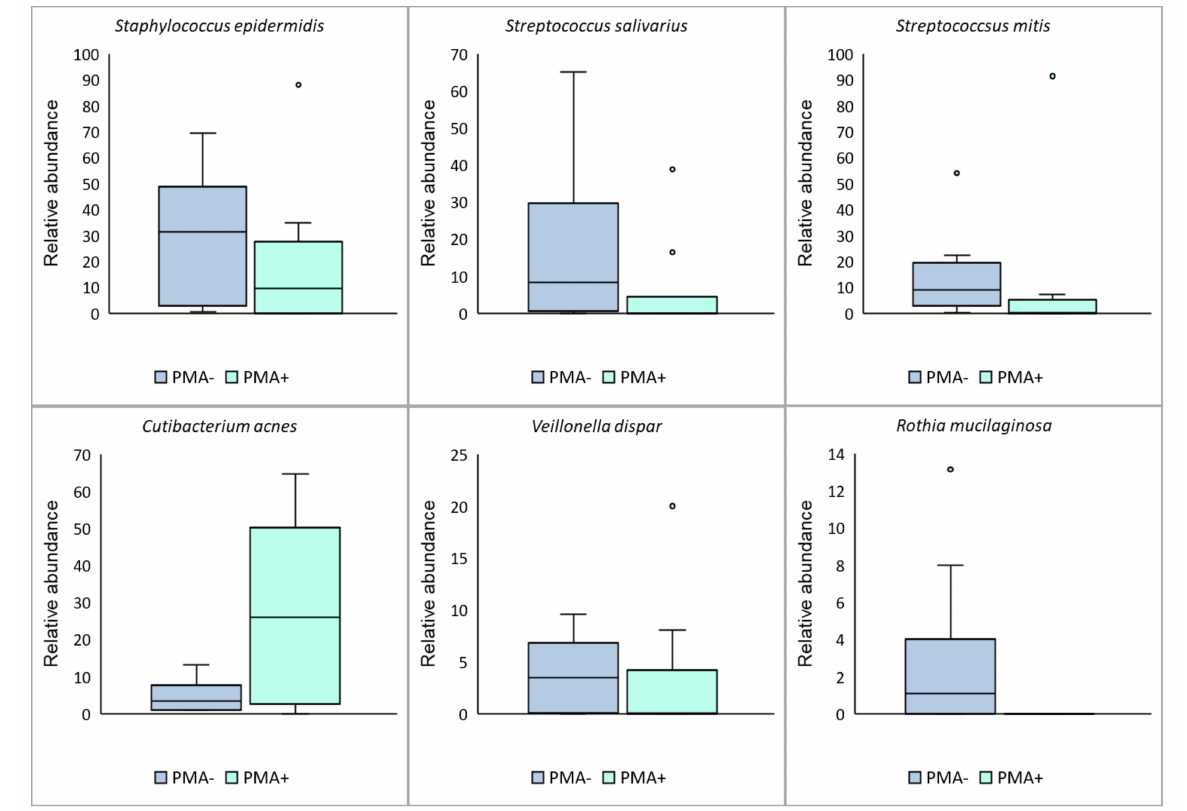
Figure 4. PMA treatment resulted in changes to the relative abundance of the top six OTUs ( ≥ 1% relative abundance, ≥ 10% prevalence) in human milk samples. The dark blue bar represents total DNA from viable and non-viable cells (non-PMA treated samples). The light blue bar represents DNA from viable cells only (PMA-treated samples). Boxes are interquartile range, whiskers are range, and inner lines are medians. Cutibacterium acnes relative abundance was significantly higher in PMA-treated compared to untreated samples (generalized additive model for location, scale and shape fit with a zero-inflated beta distribution; p =